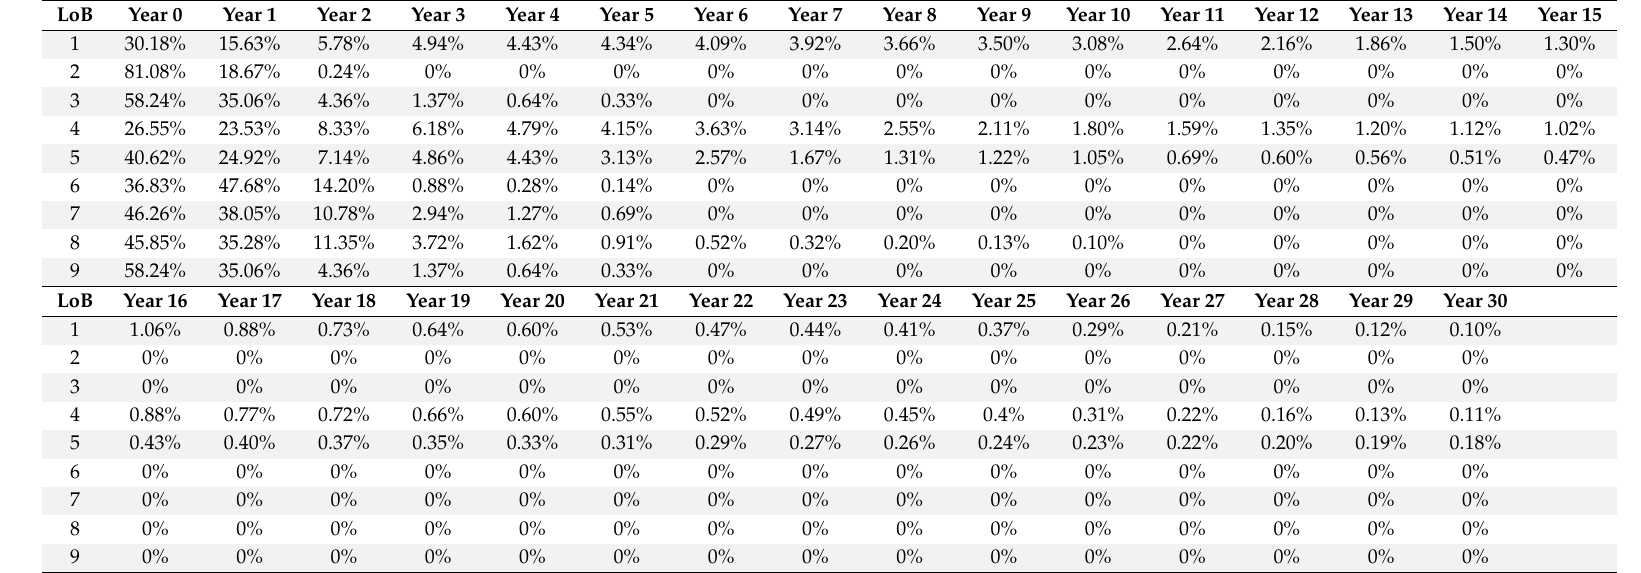
Table 3. Swiss Solvency Test (SST)’s (2015) standard development patterns for claims provision (normalized to have at most 30 development years and rounded to 2